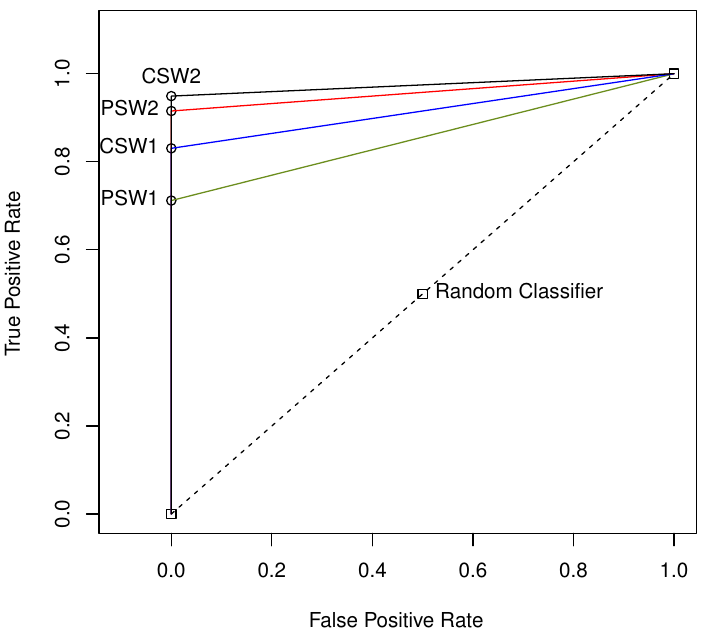
Figure 3. ROC plots for the problems with class label variables ACE with IR =